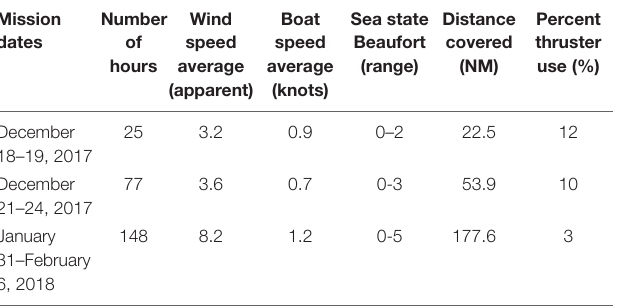
TABLE 2 | Summary of the environmental conditions and the Nav2 ASV performance during harmful algae bloom tracking deployments. Mission dates